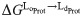
The effect of SDPE on the free energies of transfer of proteins between the Lo and Ld phases.A) Values for A2AR are shown in black solid line. A negative sign of the free energy of transfer indicates A2AR to favor the Ld phase. Inset shows the free energy changes ΔGLoProt→LdProt and ΔGLo→Ld of the alchemical transformations (DSPC→DOPC) with and without A2AR, respectively. B) Free energies of all studied proteins in the absence and presence (16 mol%) of SDPE. The more realistic membrane compositions are denoted with “real.”.